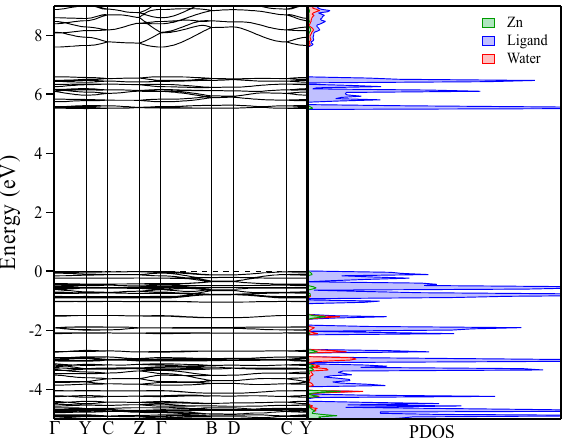
Figure 7. Band structure and partial density of states (PDOS) calculated with the B3LYP functional for compound 1 using the experimental X-ray diffraction structure.